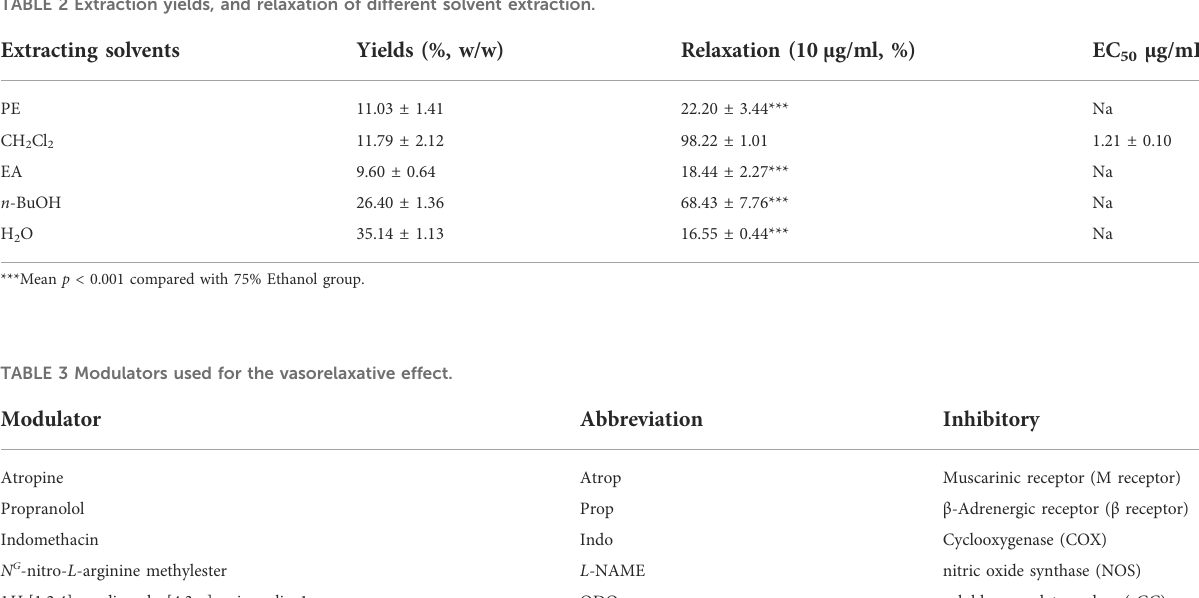
TABLE 2 Extraction yields, and relaxation of different solvent extraction.